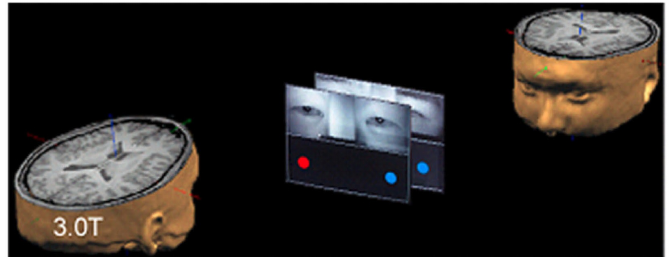
Figure 3. A co-ordination task, as described by [33].